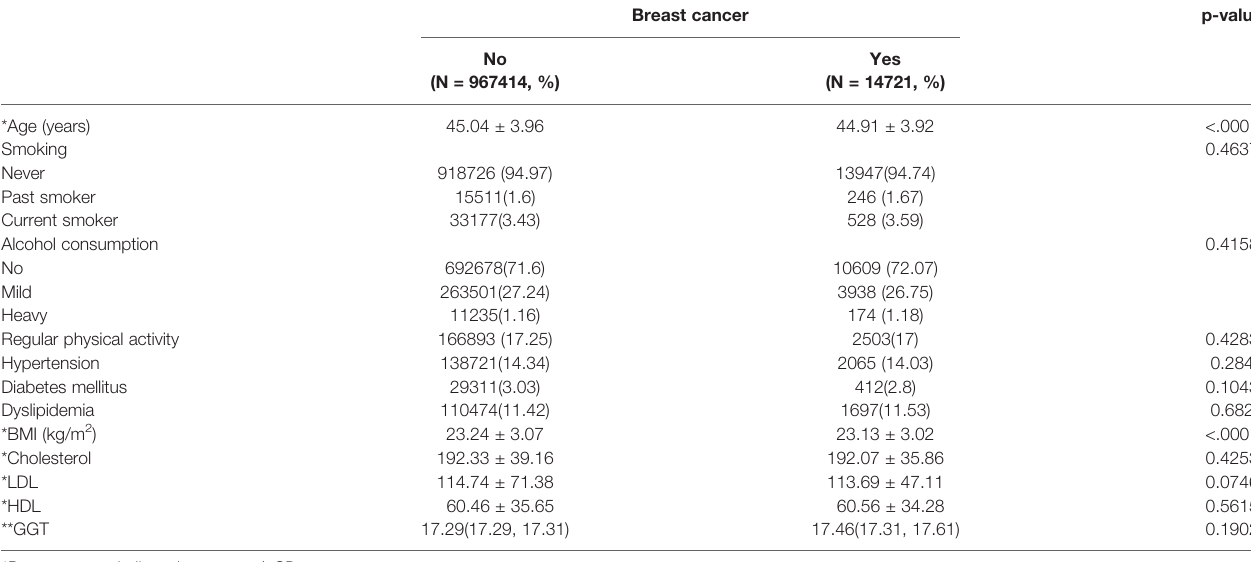
TABLE 2 | Baseline demographic and clinical data according to female cancer status in post-menopausal women.